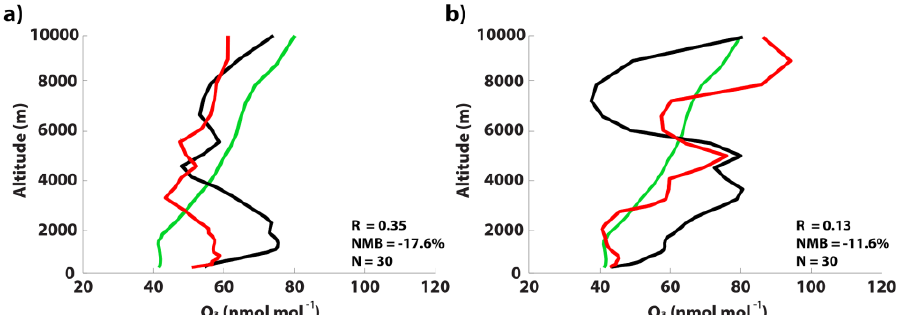
Figure 2. GEOS-Chem-predicted (red line) and TOLNet-observed (black line) average O 3 mixing ratios (nmol mol −1 ) on ( a ) 12 June 2013 between 02 UTC and 08 UTC and ( b ) 29 June 2013 between 01 and 05 UTC. Monthly-averaged vertical profiles of O 3 predicted by GEOS-Chem at the UAH TOLNet location during June 2013 are also displayed for reference (green line).